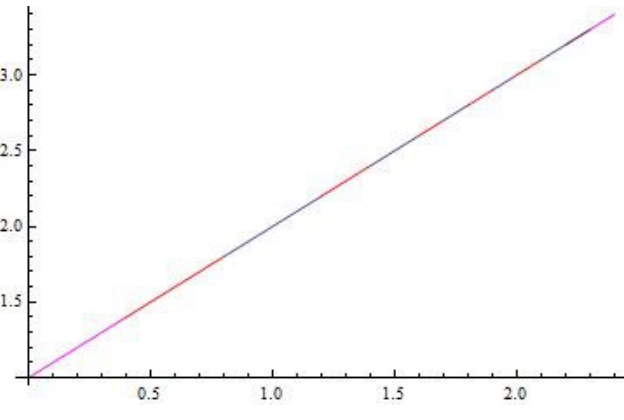
Fig. 9 Graph of the solution using AIM in the interval [ 0 . 3 , 0 . 4 ) .